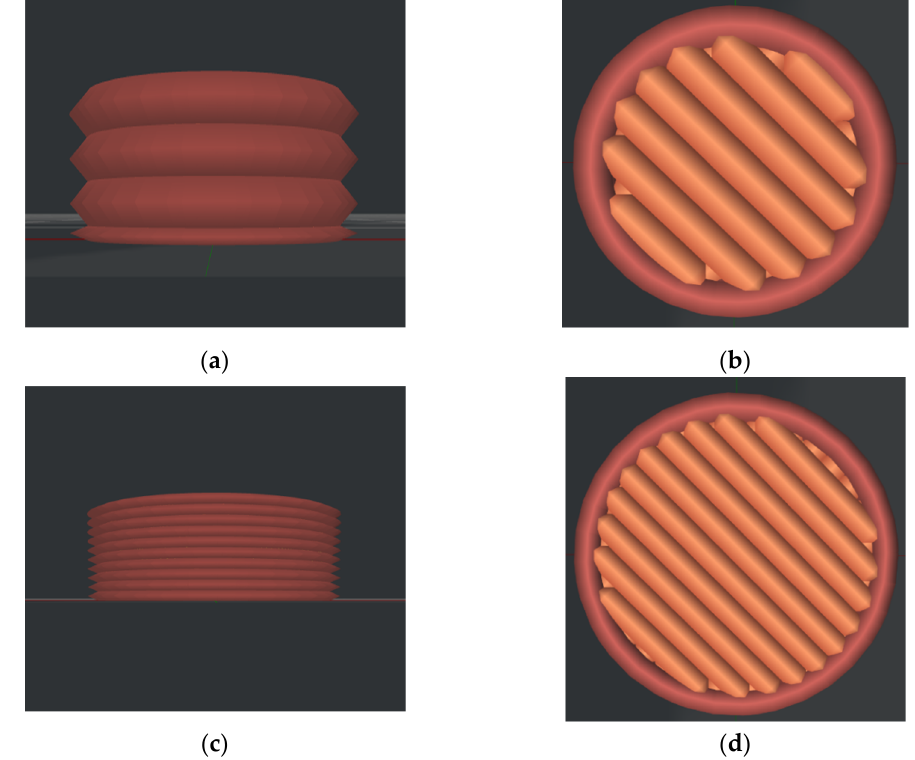
Figure 2. Sample model for printing: ( a , b ) 0.6 mm diameter nozzle and 0.3 mm layer height; ( c , d ) 0.4 mm diameter nozzle and 0.1 mm layer height (( a , c )—side views; ( b , d )—top views).